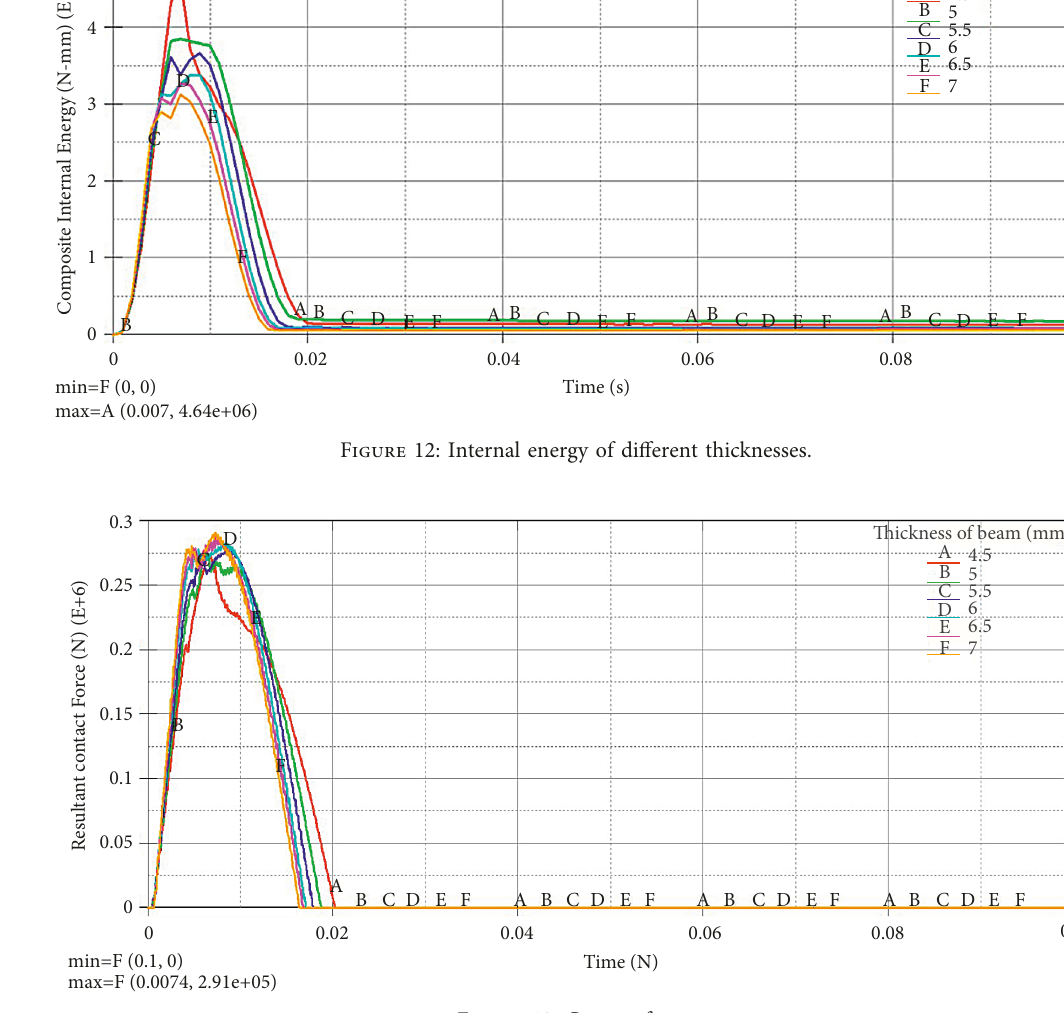
Figure 13: Contact